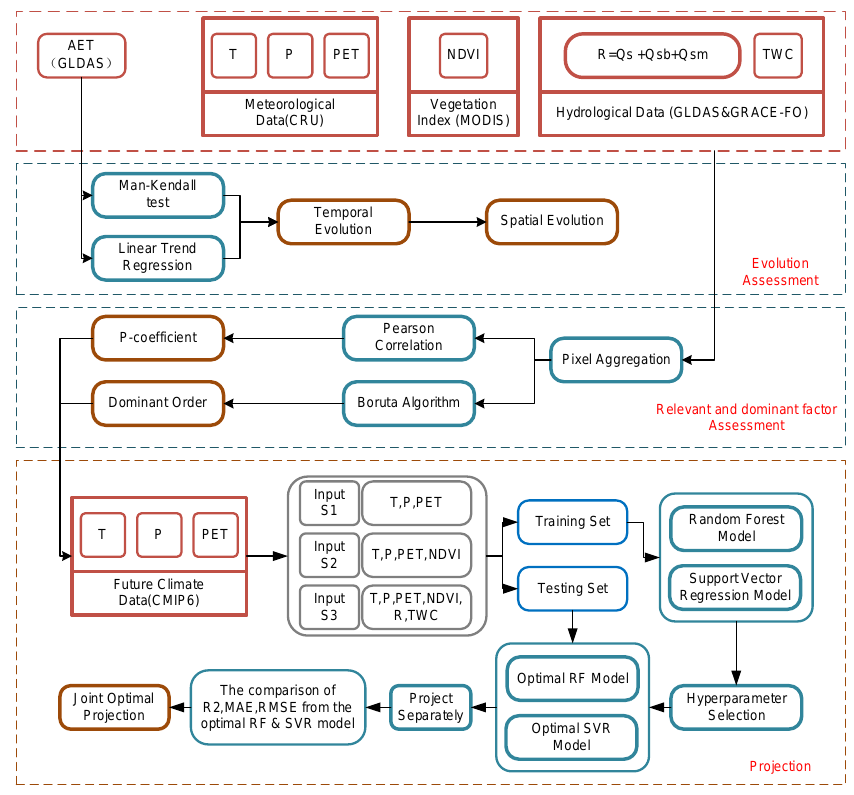
Figure 2. A framework for actual evapotranspiration assessment and projection based on meteoro- logical, hydrological, and vegetation remote sensing